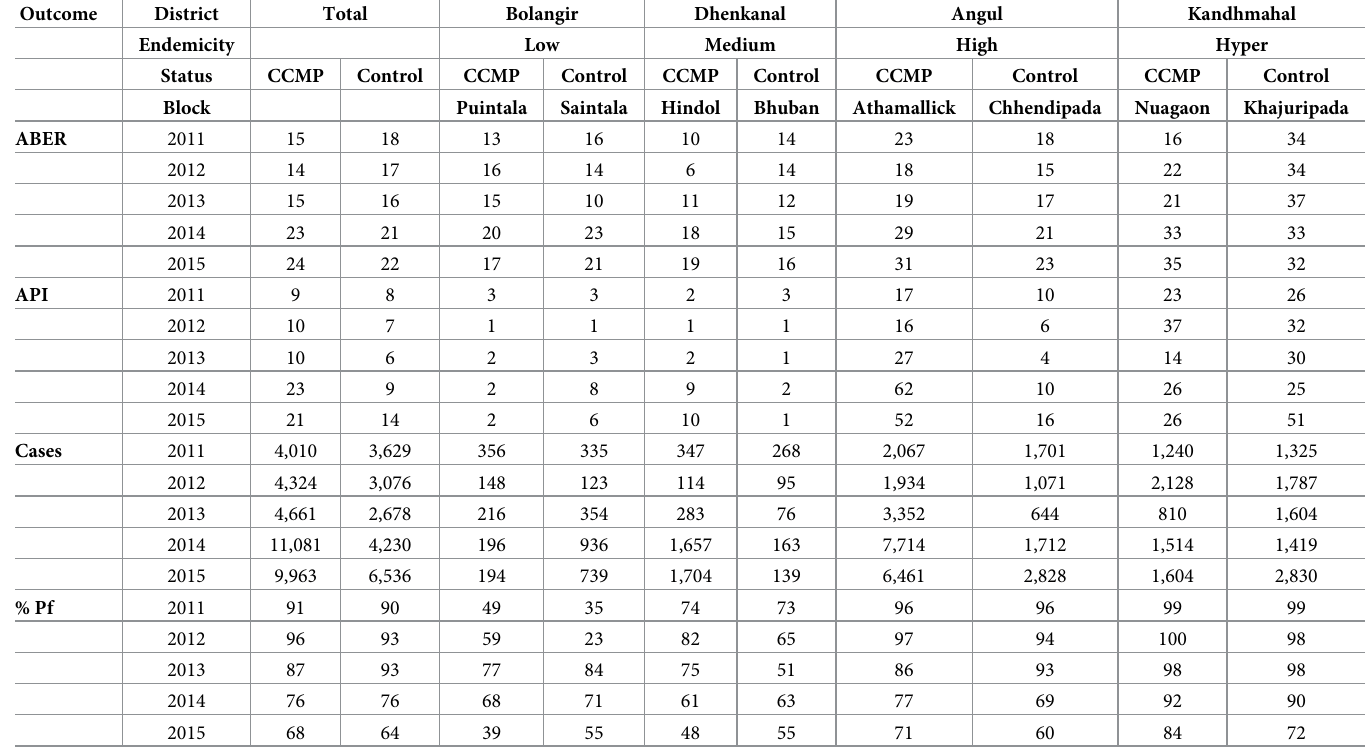
Table 2. Epidemiological overview in CCMP intervention and control areas, 2011–2015. Outcome District